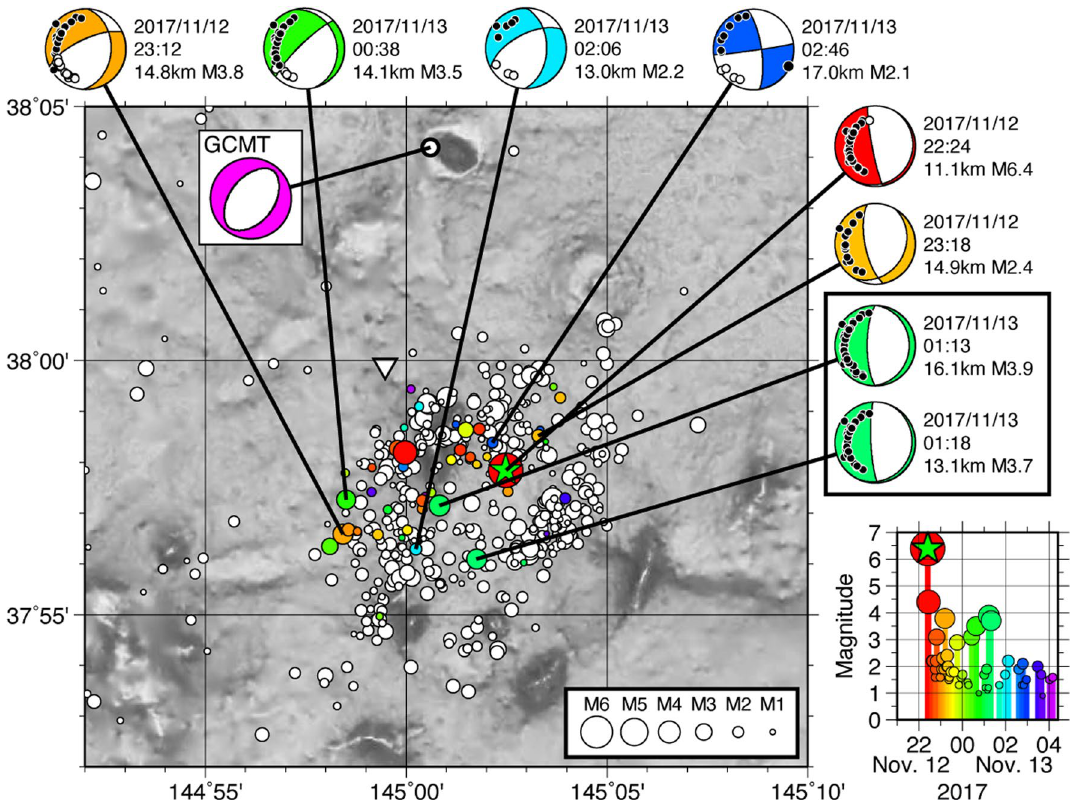
Fig. 9 Focal mechanisms and first-motion polarities of the November 12, 2017 earthquake and its aftershocks. The epicenter of the mainshock is marked with a green star. Earthquakes within 6 h from the mainshock are indicated by circles color-coded with time after the mainshock as in the magnitude-time diagram in the bottom right panel. Note that the time range differs from that in Fig. 8. Focal mechanisms are indicated with first-motion polarities. Two focal mechanisms within the solid rectangle are ranked as quality B by the HASH program (Hardebeck and Shearer 2002). The other six focal mechanisms are ranked as quality